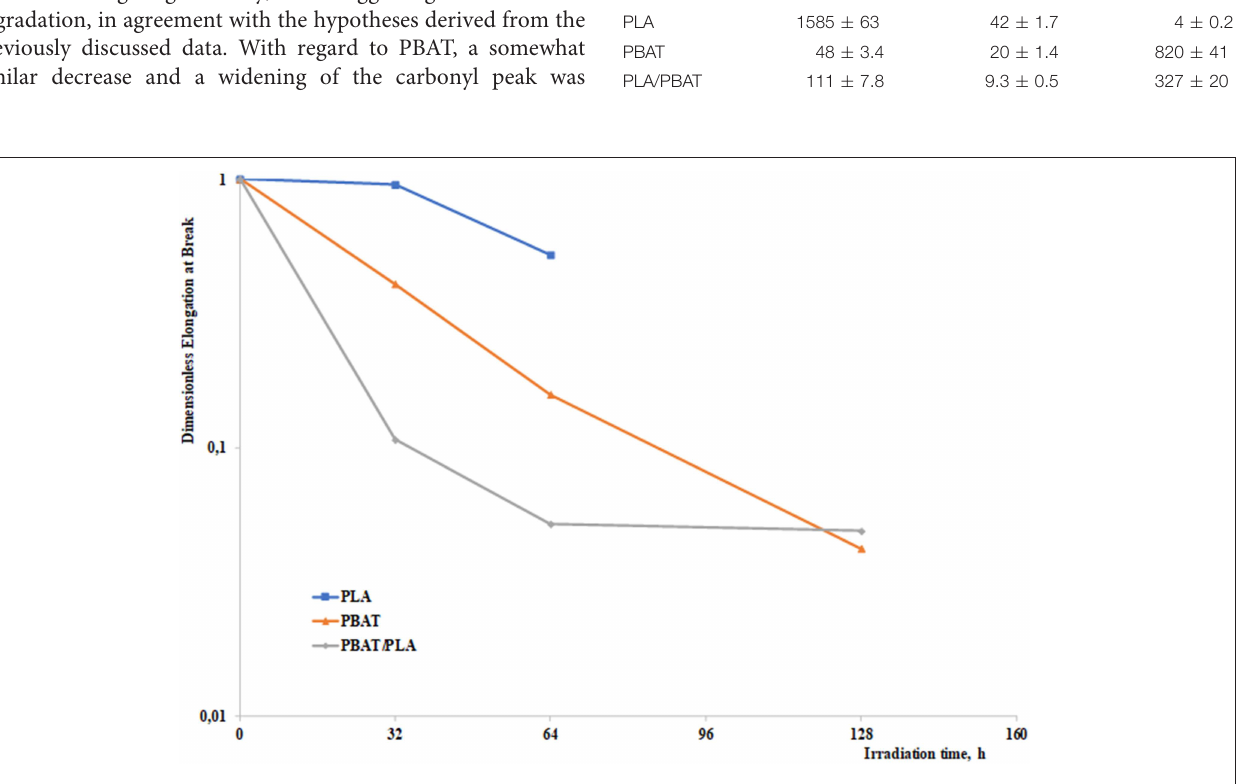
Frontiers in Materials |